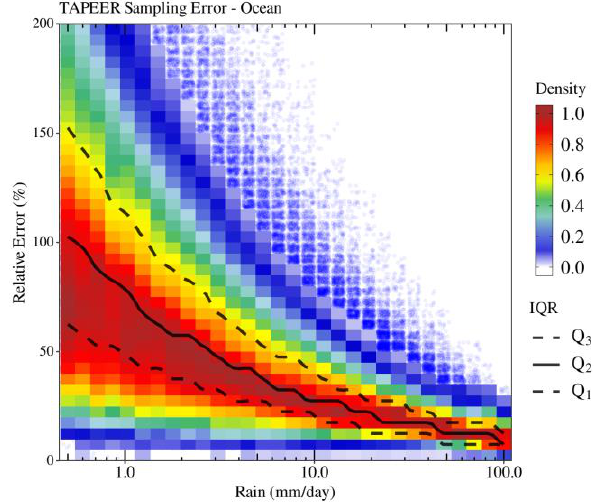
Figure 2. The uncertainty distribution due to sampling ( y -axis, in %) as a function of the daily precipitation ( x -axis, in mm day −1 ) for June-July-August of 2014, between 30° N/S and over oceanic surfaces from TAPEER product. Panel shows the density scatterplot (colored scale) superimposed by the log-binned IQR distributions (in black) of the relative error vs. the daily accumulated precipitation (log-scale distributed). Outliers are represented by blue dots.